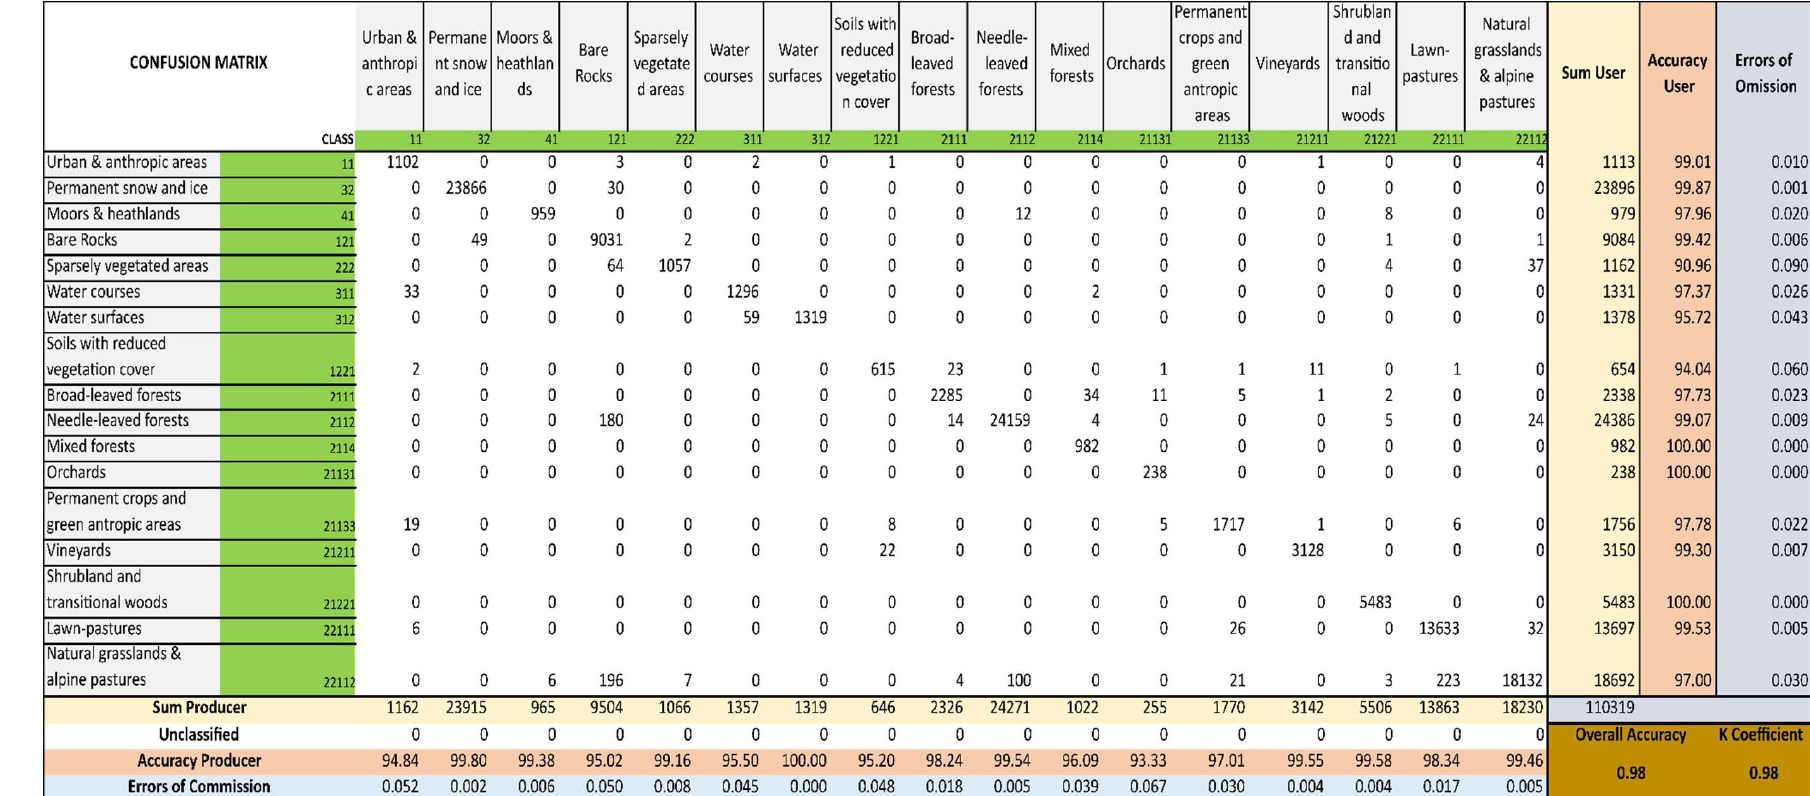
Figure 7. Final Confusion matrix.